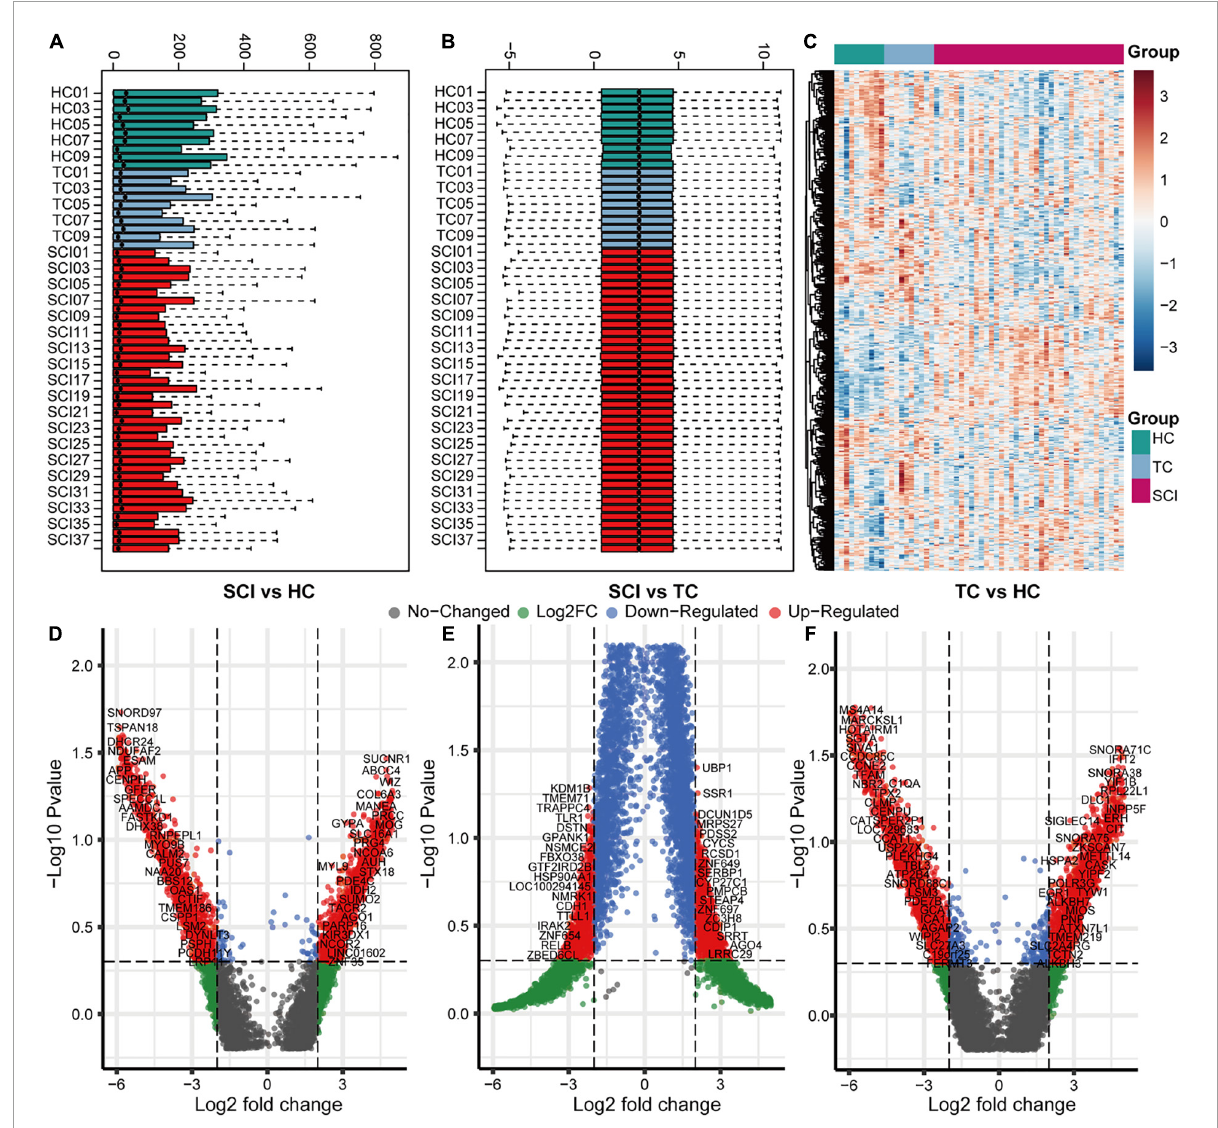
FIGURE2 Overall gene expression profiles of peripheral blood leukocytes in acute SCI patients. (A,B) GSE151371 chip data before and after background correction. (C) Heatmap of the overall expression of GSE151371 chip data. (D–F) Volcano plots of differentially expressed genes between the SCI and HC groups, SCI and TC groups, and TC and HC